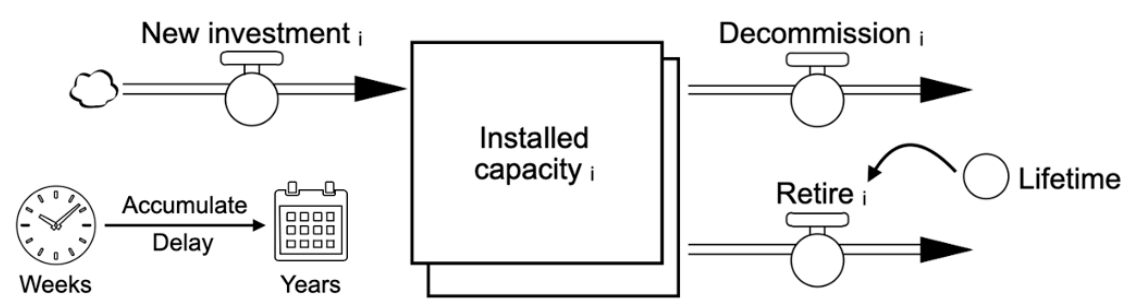
Figure 3. Stock-flow diagram of capacity change.